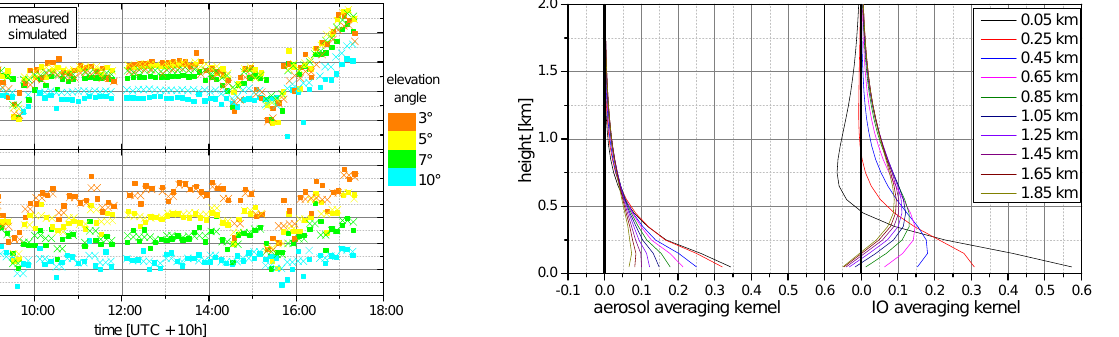
Fig.5: Dailyaveraged IO dSCDsmeasuredforelevationanglesof3 ◦ (red)alongthecruise track with the dSCD detection limits displayed by blue bars (left panel). In the right panel, all inferred IO dSCDs are shown and colour-coded for different elevation angles.